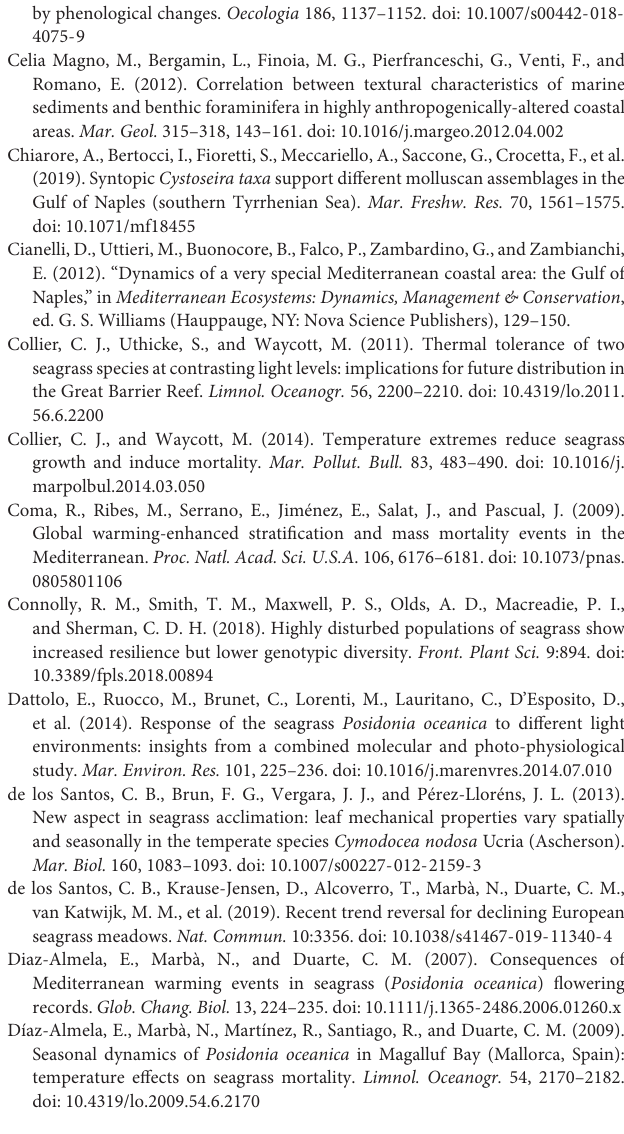
Supplementary Figure 1 | Sea surface temperature (SST) data recordings for years 2017 and 2018 obtained from a MEDA (Monitoring and Environmental Data Unit) type buoy placed in Bagnoli, Gulf of Pozzuoli (IRM, RIMAR department, SZN). Supplementary Figure 2 | Net shoot change measured as percentage of T0 (beginning of the experiment) in OL and EU plants after one (T1), two (T2), three (T3) and five (T4) weeks exposure to nutrient (N), temperature (T) and their combination